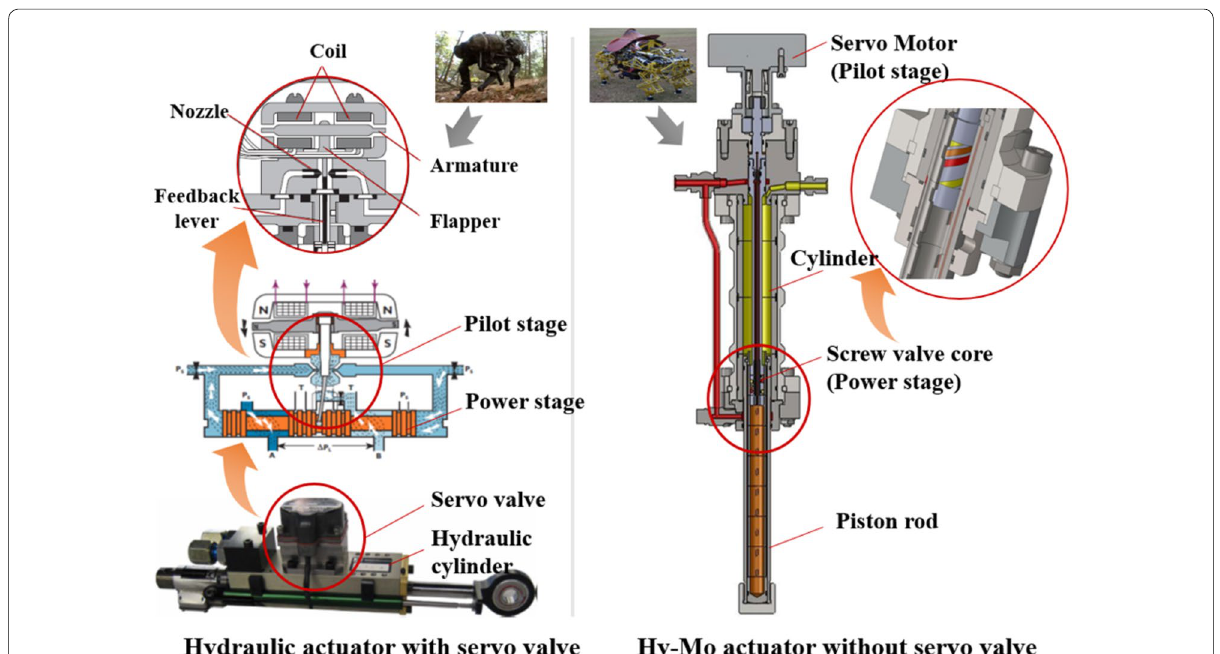
Figure 12 Comparison of the Hy-Mo actuator with traditional hydraulic actuator